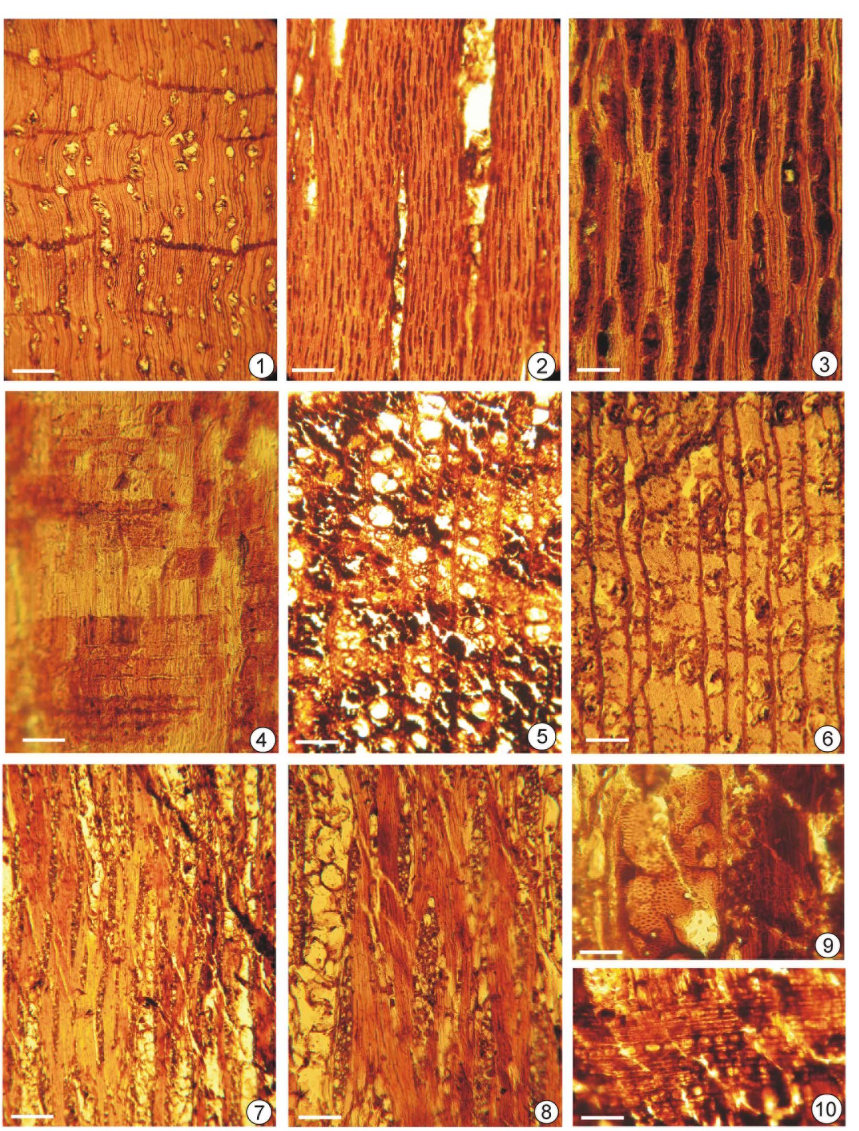
Figure 4. Wood anatomical details of Calophyllum sp. (1–4) and Careyaarborea Roxb. (5–10). 1. Transverse section showing distribution of obliquely arranged tylosed vessels and apotracheal parenchyma bands. Scale bar =250 m m; (BSIP Museum Slide No. 40078 A-1). 2. Tangential longitudinal sections showing uniseriate rays and tylosed vessel elements. Scale bar =100 m m; (BSIP Museum Slide No. 40078 A-2). 3. Tangential longitudinal sections magnified showing uniseriate rays ands solitary crystal Scale bar =50 m m; (BSIP Museum Slide No. 40078 A-3). 4. Radial longitudinal section showing heterocellular rays. (BSIP Museum Slide No. 40078 A-4). 5. Transverse section showing distribution of tylosed vessels and apotracheal parenchyma lines. Scale bar =250 m m; BSIP Museum Slide No. 40080-1. 6. Transverse section of another sample showing distribution of tylosed vessels and apotracheal parenchyma lines. Scale bar =250 m m; BSIP Museum Slide No. 40080-2. 7. Tangential longitudinal section showing distribution of multiseriate rays and tylosed vessels. Scale bar =250 m m; BSIP Museum Slide No. 40080-3. 8. Tangential longitudinal section enlarged of another sample showing a multiseriate rays. Scale bar =100 m m; BSIP Museum Slide No. 40080 - 4. 9. Tangential longitudinal section showing bordered, alternate hexagonal intervessel pits. Scale bar =50 m m; BSIP Museum Slide No. 40080 -5. 10. Radial longitudinal section showing heterocellular ray cells. Scale bar =100 m m. BSIP Museum Slide No. 40080 - 6.